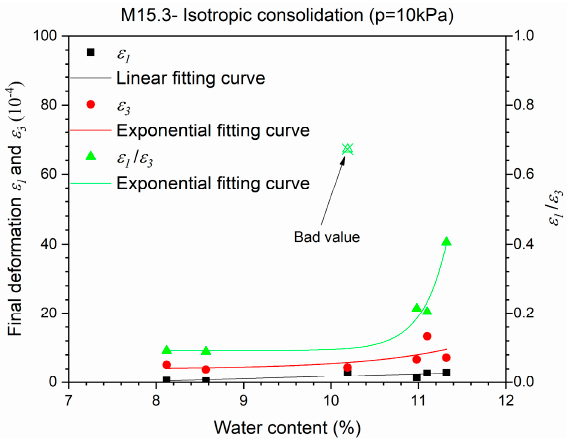
Figure 5. Final deformations ε 1 and ε 3 for Missillac sand M15.3 in an isotropic consolidation phase before conditioning.